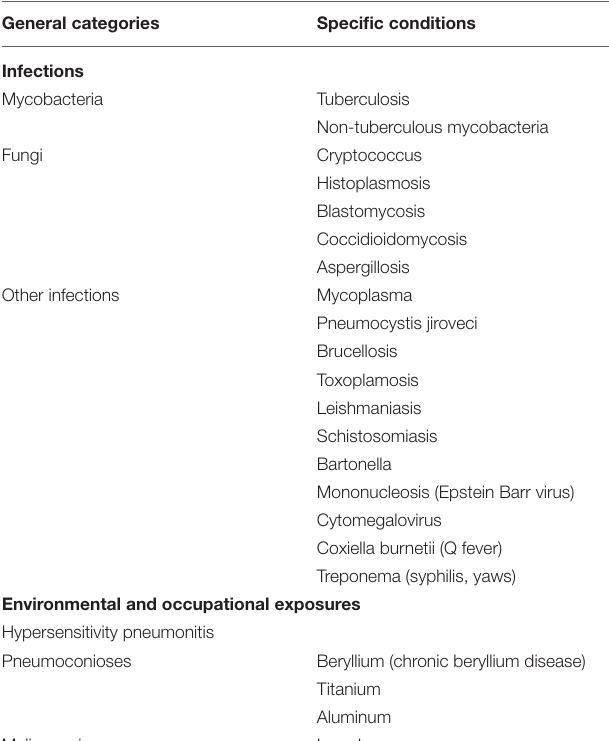
TABLE 1 | Potential granulomatous mimics of